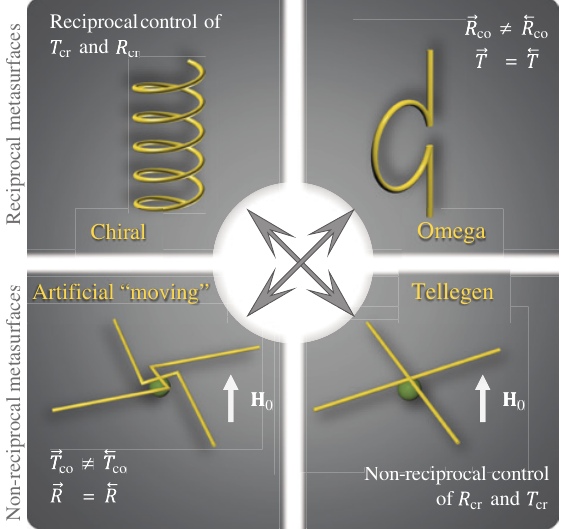
Figure 12: Illustration of functionalities enabled by uniform bianiso- tropic metasurfaces of four different classes. The arrows above the reflection R and transmission T coefficients indicate different direc- tions of